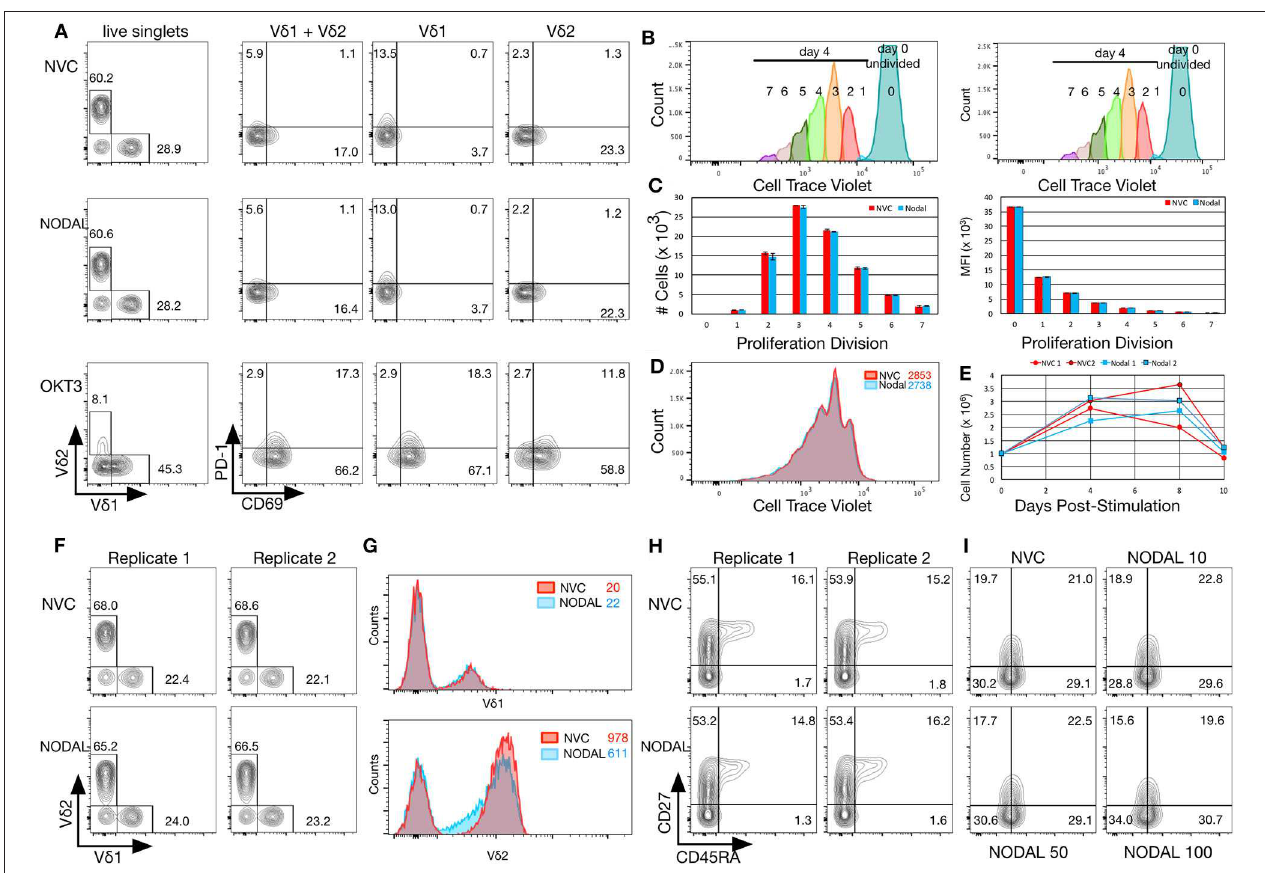
FIGURE 3 | NODAL stimulation has no impact on activation markers, proliferation or maturation of γδ T cells but longer term exposure to NODAL results in decreased V δ 2 TCR surface expression. (A) , γδ T cells were subject to 24h 100ng/ml NODAL stimulation, and then surface expression of V δ 1 and V δ 2 TCR, PD-1, and CD69 were assessed via flow cytometry. NVC, NODAL vehicle control; anti-CD3 (OKT3) stimulation was done as a positive control for activation markers. This is a representative example of n = 3 independent experiments. (B) , Long term NODAL stimulation has no impact on γδ T cell proliferation. γδ T cells from the same culture as in A were labeled with Cell Trace Violet, then stimulated one time with NODAL vehicle control (NVC) or 100ng/ml recombinant human NODAL. Flow cytometry was performed on days 0, 4, 8, and 10. Proliferation modeling analyses for the day 4 time point are shown. (C) , Cell numbers and median fluorescence intensities (MFI) of proliferation divisions for the experiment shown in B are shown; n = 2 technical replicates, error bars are SD. (D) , A representative example of histogram overlays from the day 4 time point of the experiment shown in B and C; MFIs are indicated. (E) , Cell counts on days 0, 4, 8, and 10 are plotted here for the two technical replicates done in the experiment shown in (B–D) . No significant differences were observed. (F) , Ten days after NODAL stimulation, cells cultured in parallel with the experiment in B-E were stained for V δ 1 and V δ 2 TCR expression; results from two technical replicates are shown. (G) , Histogram overlays and MFIs of TCR expression for representative examples from the experiment shown in (F) . (H) , For the experiment shown in (F,G) , maturation was assessed via CD45RA and CD27 staining; both technical replicates are shown. (I) , Maturation assessment after stimulating γδ T cells for 4 days with 10, 50, or 100ng/ml recombinant human